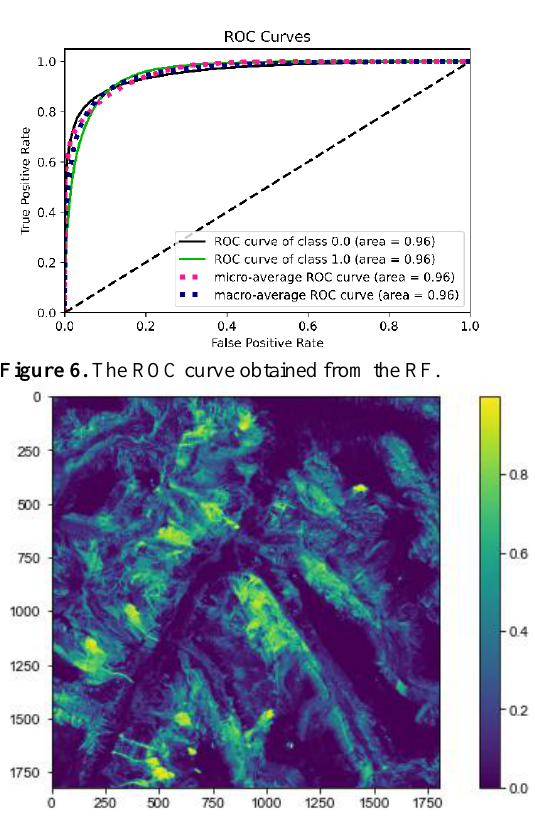
Figure 7. The spatial distributions of the avalanche probabilities were obtained from the RF.